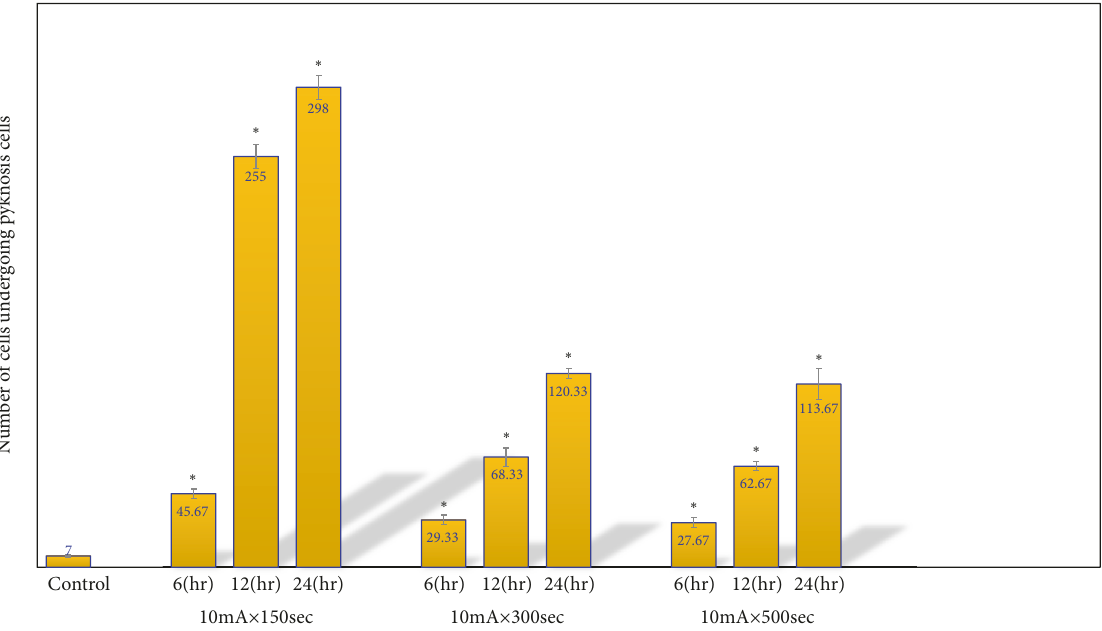
Figure 18: Microscopic finding of squamous cell carcinoma (1x1 cm) occurring on the right upper thigh after inoculation of SCC-7 in 10mA × 150sec group, 10mA × 300sec group, and 10mA × 600sec group. Tissue section taken 6, 12, and 24 hours after treatment. There are many pyknosis neoplastic cells and also some typical spindle cells with mitosis (H & E, x400). ( ∗ p < 0.05 ). The results represent ± S.D. from 8 to 10